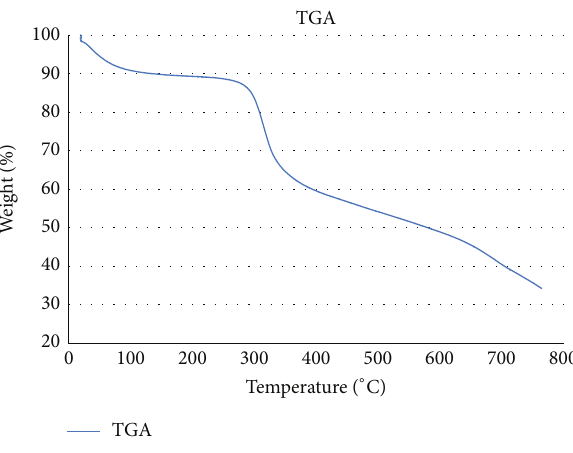
Figure 5: Thermal gravimetric curve of the catalyst composite.